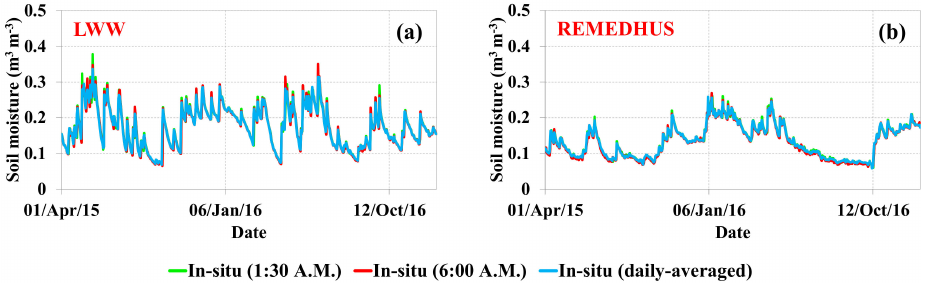
Figure 2. Temporal evolution of the station-averaged soil moisture at different times (daily, 1:30 A.M. and 6:00 A.M.) for ( a ) LWW, and ( b )